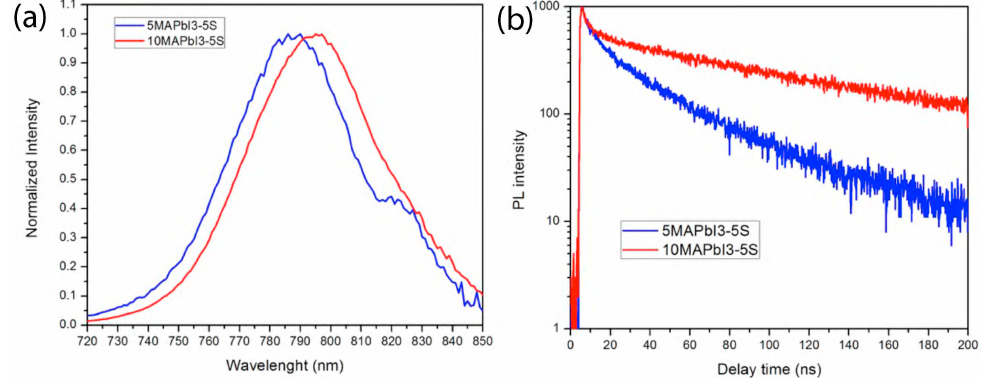
Figure 8. Photoluminescence (PL) spectra ( a ) and PL lifetime decay ( b ) of 5MAPbI 3 -5S and 10MAPbI 3 -5S printed pattern film.